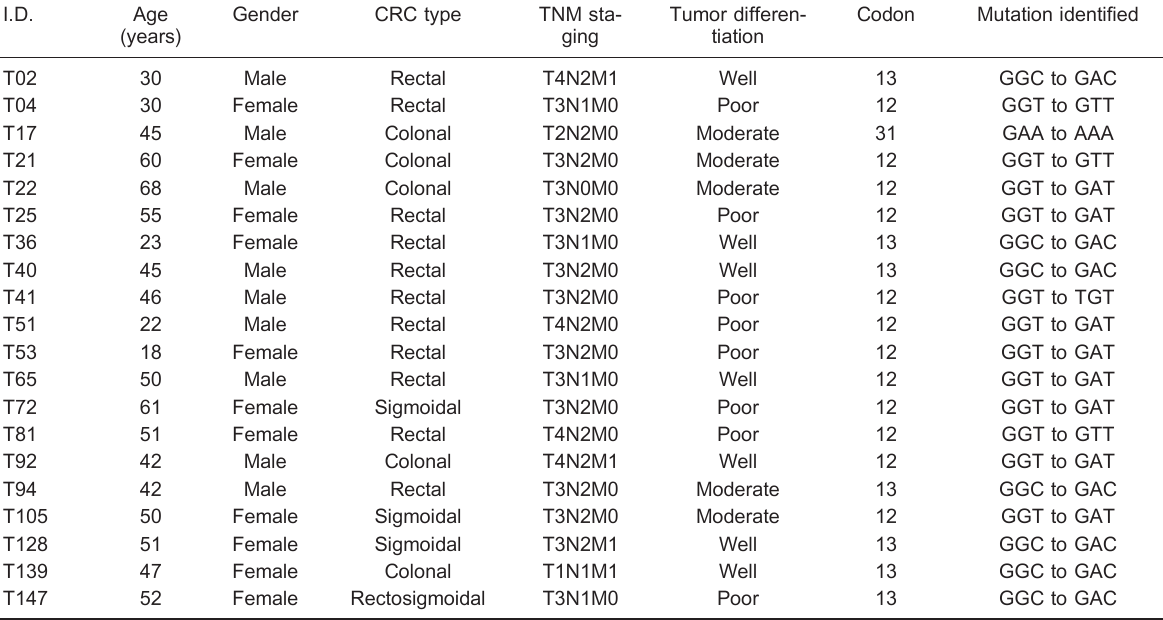
Table 2. Mutational analysis of the K ras gene in Pakistani colorectal cancer (CRC) patients.